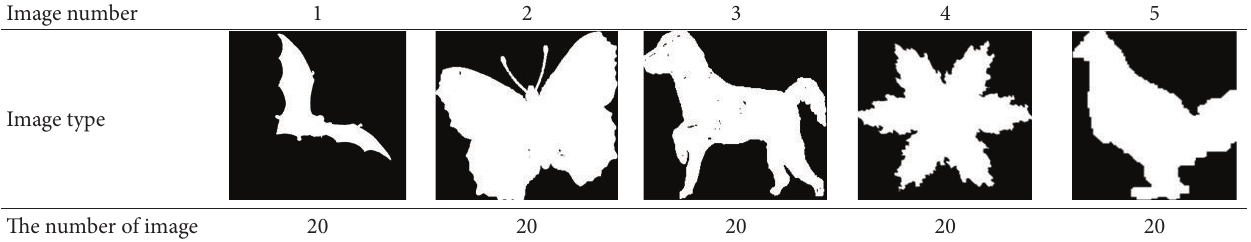
Table 2: Some query images in the MPEG-7 image